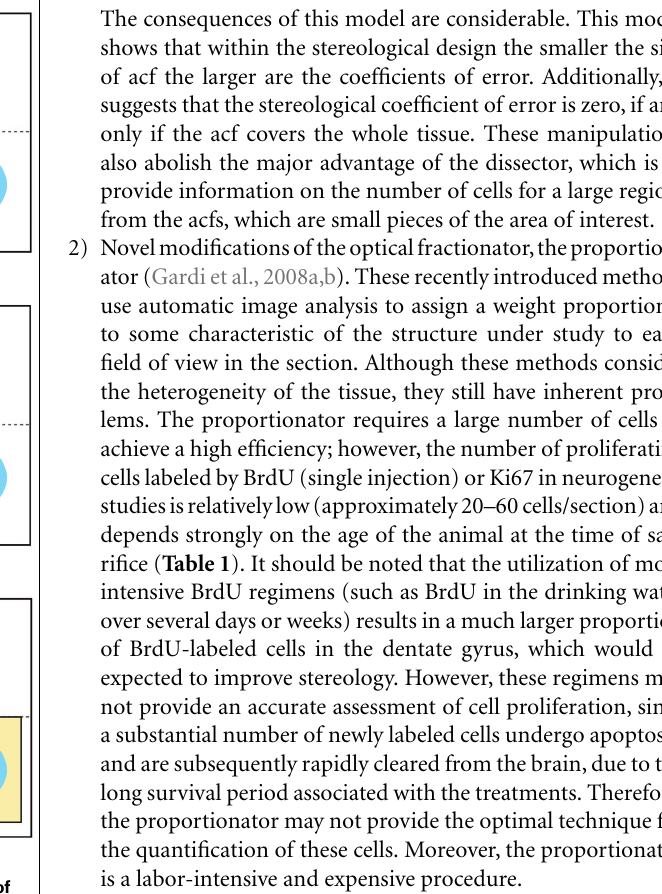
FIGURE 1 | Schematic representation of different sizes of the “area of the counting frame” ( acf , shown as rectangular beige windows), superimposed on the dentate gyrus of the hippocampus (granular cell layer shown in blue and labeled proliferated cells depicted as brown dots). Enlargement of the acf by optical fractionators is a common method used to improve the accuracy of the quantification results. For example, in (A) none of the labeled cells fall within the small counting frames, whereas in (C) , the larger counting frames capture all of the labeled cells, due to the irregular distribution of the labeled cells. Increasing the size of the acf s clearly gives better results, but the existence of labeled cell clusters (non-homogeneity) suggests a strong dependency between the size of the acf s and the efficacy of this technique [note that the cell cluster located near the apex of the dentate gyrus is captured by the counting frames in (C) but not (B) ].The large acf s depicted in (C) cover most of the area of the dentate gyrus and therefore, the counting results are comparable with absolute cell counting for the same area.